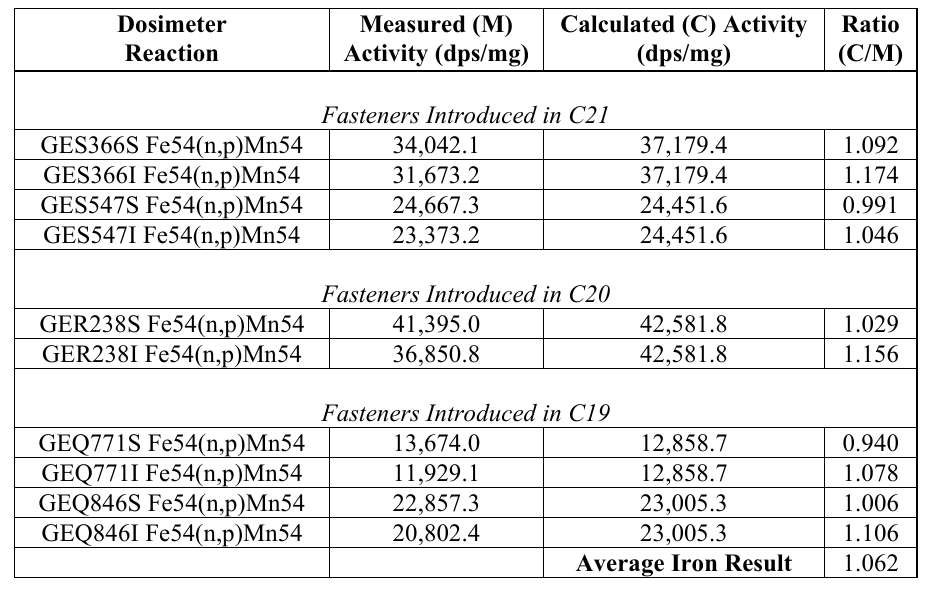
Table 1. CFD model dosimetry benchmark